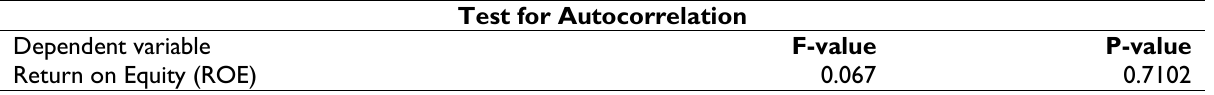
Table 4: Wooldridge Test for Serial Autocorrelation